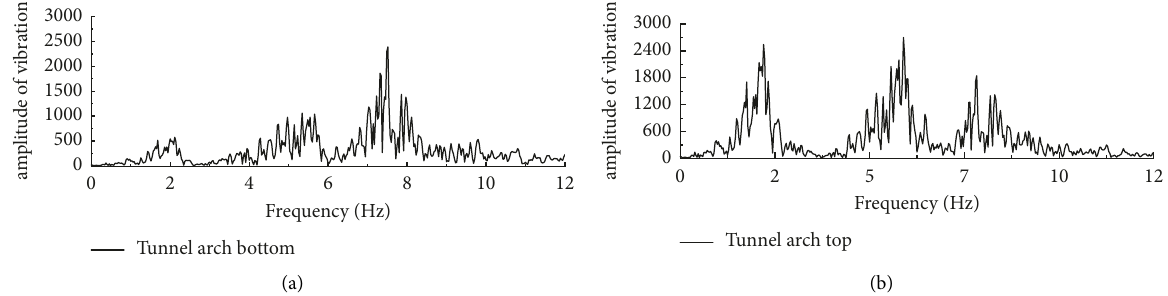
Figure 14: Fourier transform curves of the acceleration of the tunnel structure. (a) Bottom of tunnel structure. (b) Top of tunnel